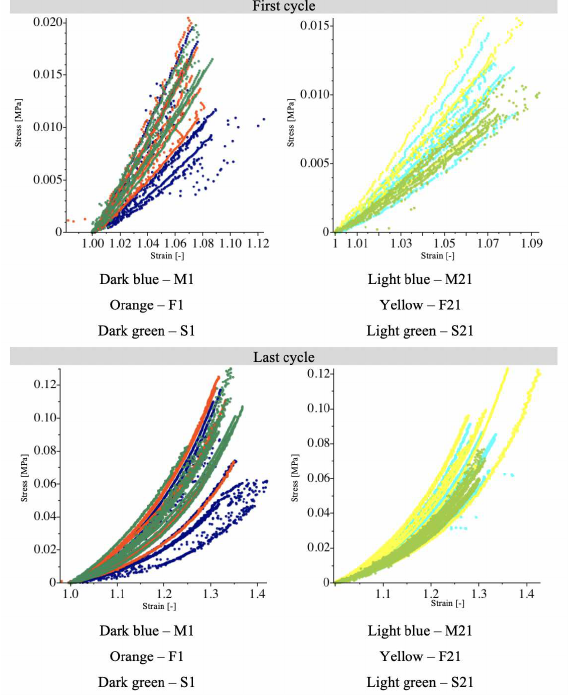
Figure 4. Stress-strain graphs for the first and last load cycles. For specimens exposed in 1. (M1) and 21 (M21), samples with fibroblasts (F1) and day 21 (F21) and samples with osteoblasts (S1) and day 21